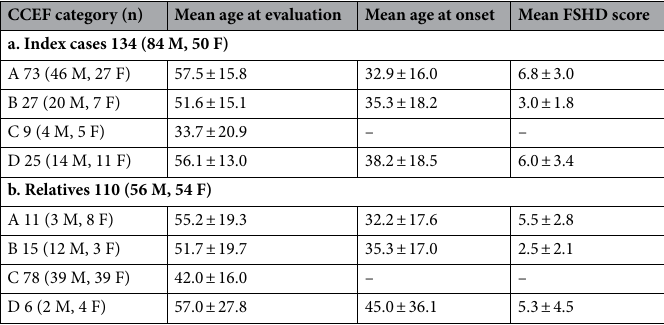
Table 1. Distribution of clinical categories among subjects carrying a